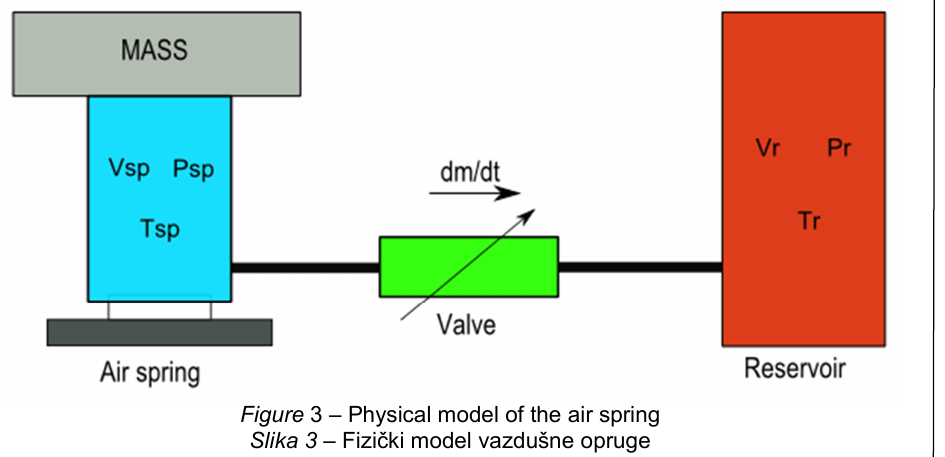
Figure 3 – Physical model of the air spring Рис . 3 –